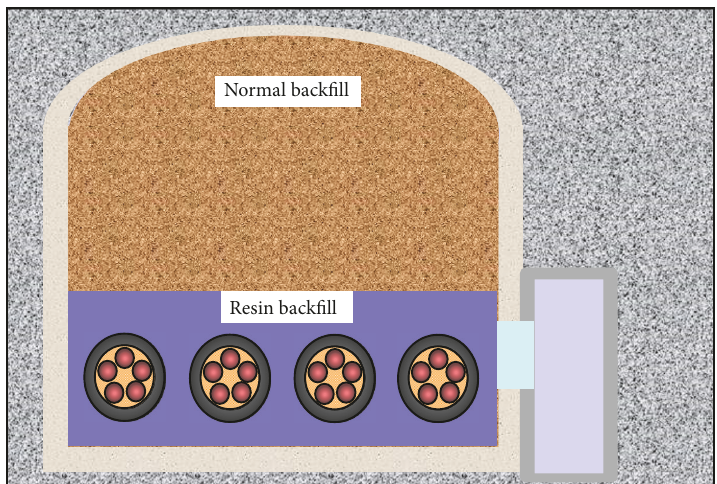
Figure 3: Optimised CARE cavern backfilling option.